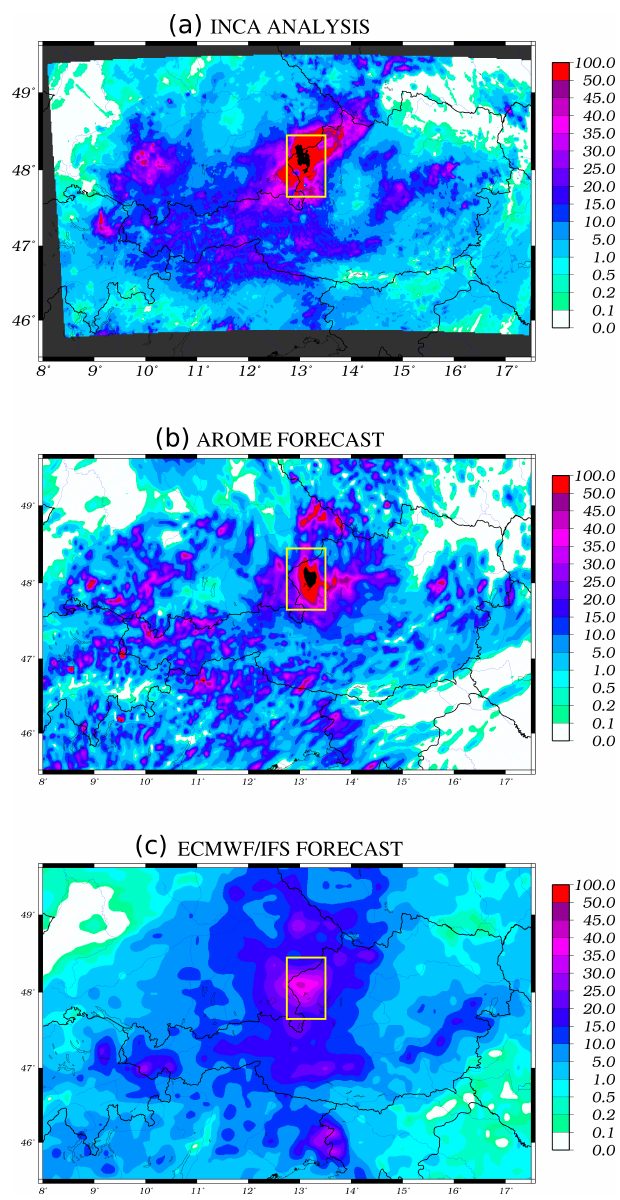
Figure 8. (a) INCA precipitation analysis for the 24h period